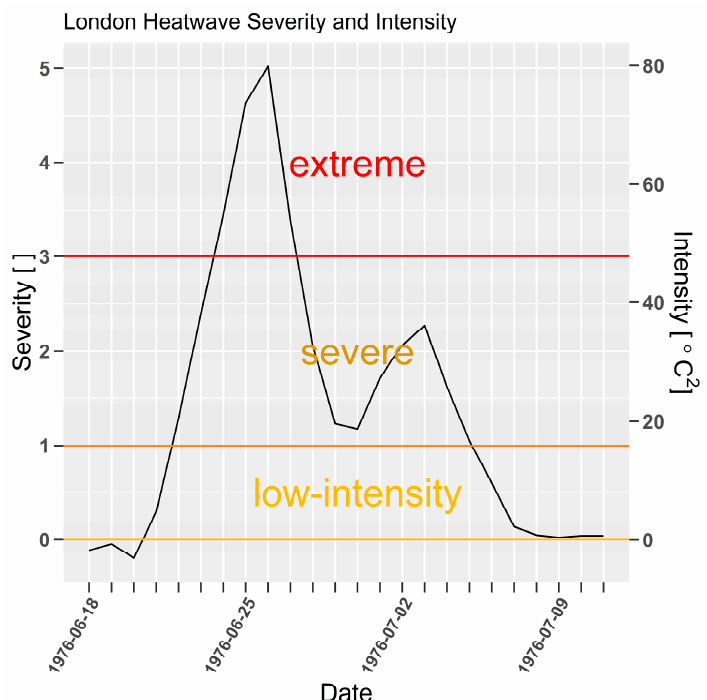
Figure 3. London (Heathrow) EHF severity and intensity for 1976 heatwave, calculated using site data. Dimensionless heatwave severity [] and intensity ( EHF , [°C 2 ]) on left and right y -axes respectively.